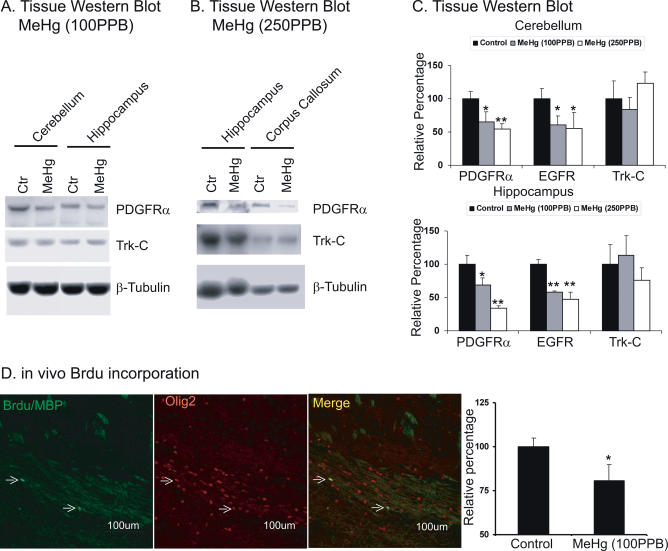
In Vivo Analysis Confirms That Developmental Exposure to Low Levels of MeHg Is Associated with Specific Reductions in Levels of PDGFRα and EGFR, but Not of TrkC, and with Reductions in O-2A/OPC DivisionTreatment of SJL mice with 100 or 250 ppb MeHg in the maternal drinking water during gestation and suckling was associated with reductions in levels of PDGFRα in the cerebellum and hippocampus at postnatal day 7 (P7), and in hippocampus and corpus callosum at P21. In contrast, levels of the NT-3 receptor TrkC (which does not appear to be a c-Cbl target) were not reduced in these animals.(A) Animals were treated with 100 ppb MeHg in the drinking water during pregnancy. Pups were sacrificed at 7 d after birth. Analysis of cerebellum and hippocampus showed clear reductions in levels of PDGFRα, but not in TrkC.(B) At P21, enough tissue could also be isolated from corpus callosum for analysis, and was found to have marked reductions in levels of PDGFRα, but not TrkC.(C) Quantitative analysis of receptor levels in P7 mice showed reductions in levels of PDGFRα and EGFR, but not TrkC. Quantitative analysis of changes in receptor expression in tissue from P7 mice. *, p < 0.05; **, p < 0.01)(D) Analysis of BrdU incorporation in Olig2+ cells reveals a reduction of approximately 20% in the number of double-positive cells in P14 animals born to mothers receiving 100 ppb MeHg in their drinking water beginning 30 d prior to conception and continuing through weaning. The top left figure shows combined labeling with anti-BrdU and anti-MBP antibodies, and the top right figure shows labeling with anti-olig2 antibodies. These images are merged in the bottom left to identify BrdU+/Olig2+ cells. Quantitative analysis of total numbers of double-positive cells reveals that developmental exposure to 100 ppb MeHg via the maternal drinking water is associated with a subtle but significant reduction in the number of O-2A/OPCs engaged in DNA synthesis, consistent with the effects of low-level MeHg exposure in vitro.Quantitative data are presented as mean percentage normalized to control animals (n = 3 for each group). Error bars represent ± standard error of the mean. The plus symbol indicates exposure of the cells to the indicated substance.